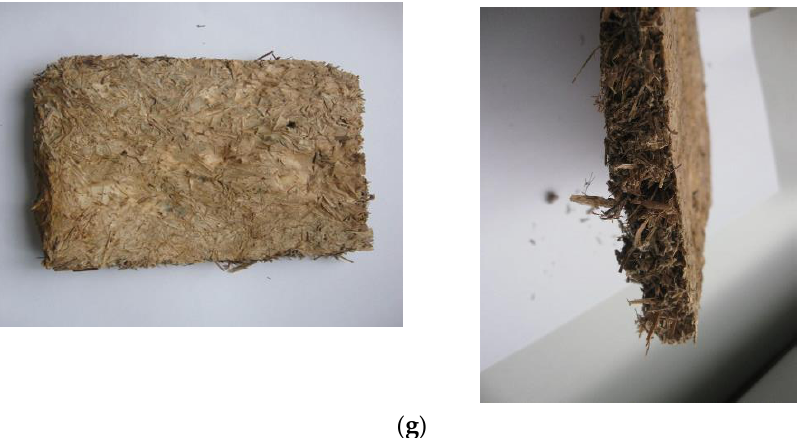
Figure 5. Preparation of biomaterial board based on fungal mycelium grown on lignocellulosic substrat (wheat straws) and polypropylene embedded with bacterial spores. ( a ) Fragments of Ganoderma mycelium prepared for boards inoculation; ( b ) Cultivation in rectangular predefined form; ( c ) Cultural bag with mycelium growth in progress (one week of incubation; arrow—white fungal mycelium); ( d ) Cultural bag with mycelium growth in progress (three weeks of incubation; arrow—white fungal mycelium); ( e ) Cultural bag with mycelium growth in progress (four weeks of incubation; arrow—white fungal mycelium); ( f ) Biomaterial board after autoclave sterilization; ( g ) Final biomaterial board (after sterilization and drying at 80 °C). Mycelium composite samples.